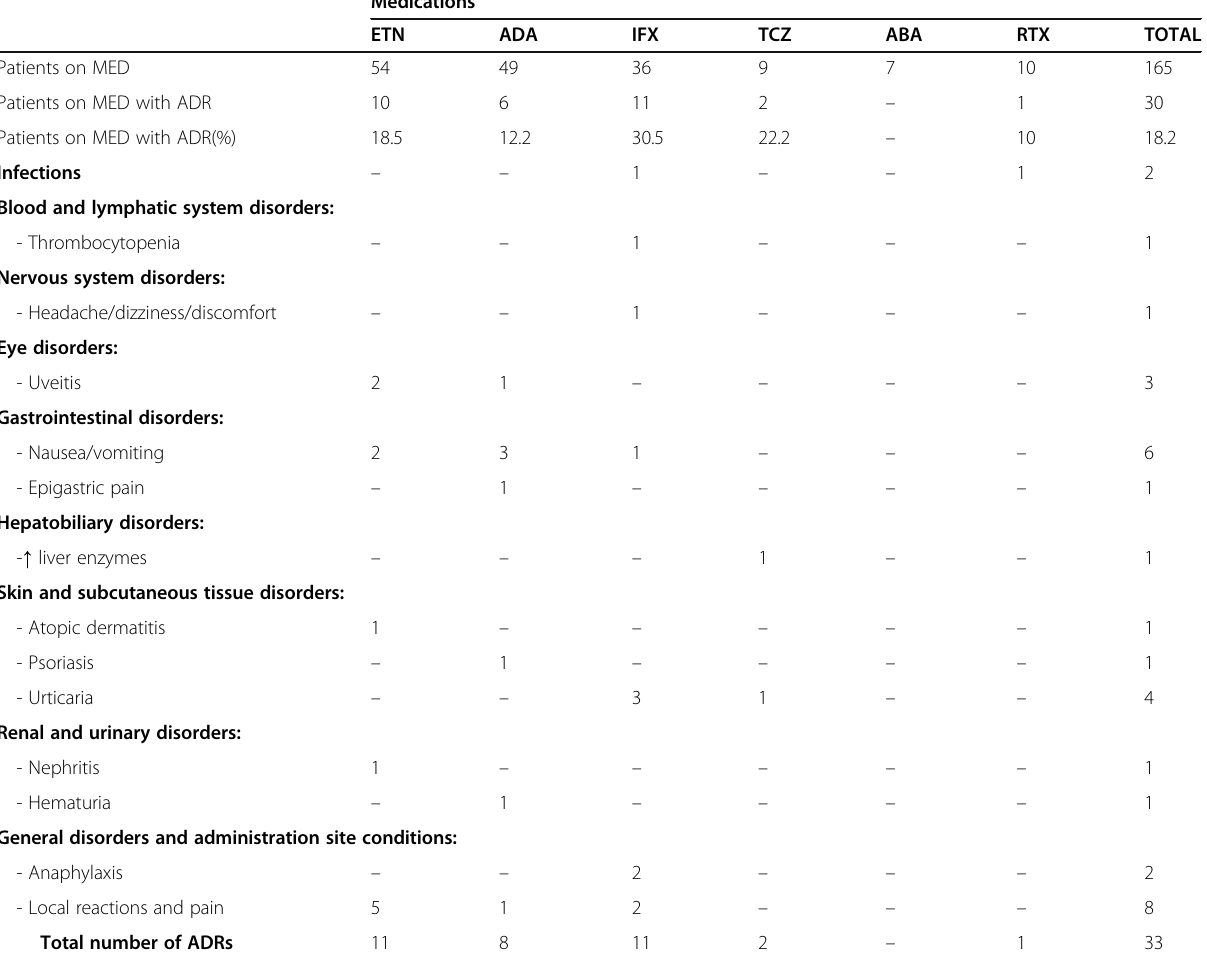
Table 2 ADRs of bDMARDs in patients with JIA, JSLE and JDM